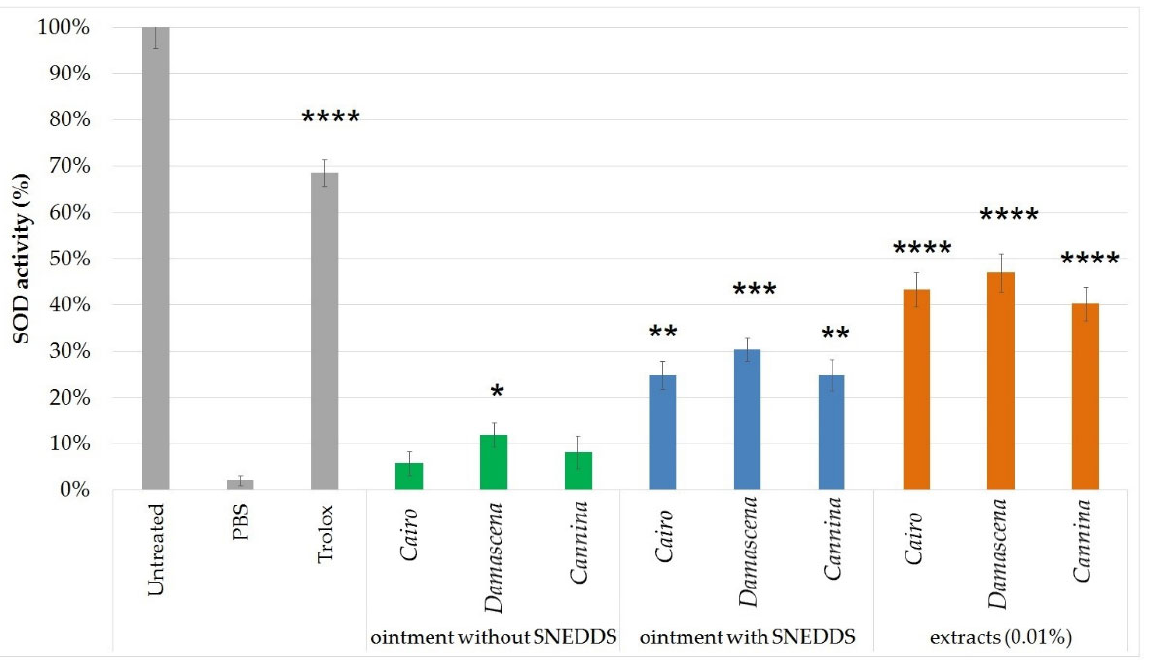
Figure 6. SOD activity of samples (green: without SNEDDS, blue: with SNEDDS, orange: extracts). SOD enzyme activity is expressed as the percentage of the enzyme activity of the cells without UV radiation (untreated). Data are expressed as mean ± SD and n = 6. Statistical significance is indicated *, **, ***, **** at p < 0.005, p < 0.01, p < 0.001, and p < 0.0001. Treated groups were compared to PBS with one-way ANOVA followed by Dunnett’s multiple comparison test.